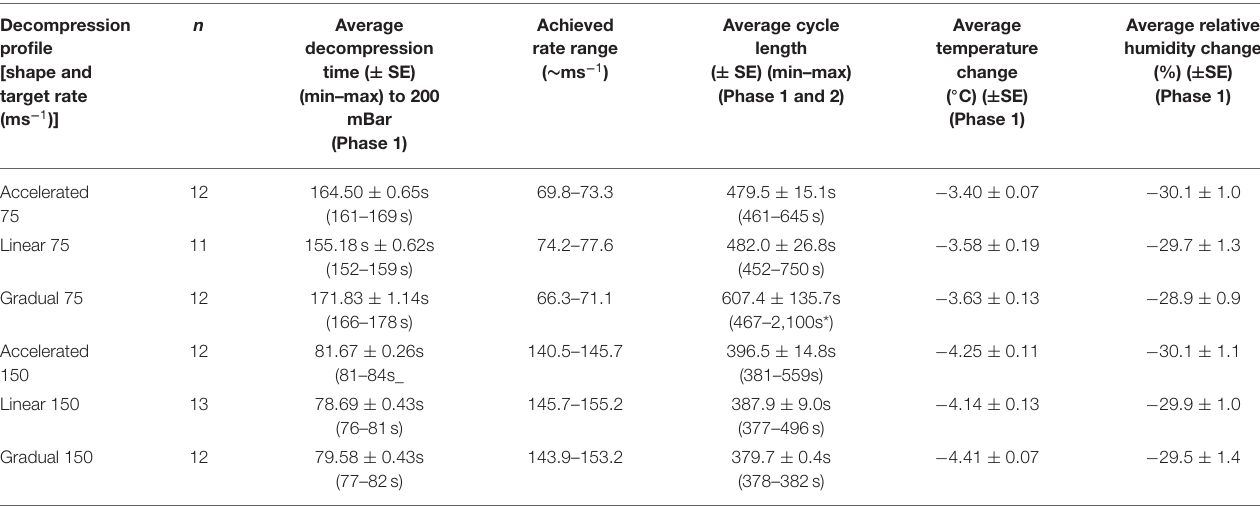
TABLE 2 | Outline of the six decompression profiles according to rate and